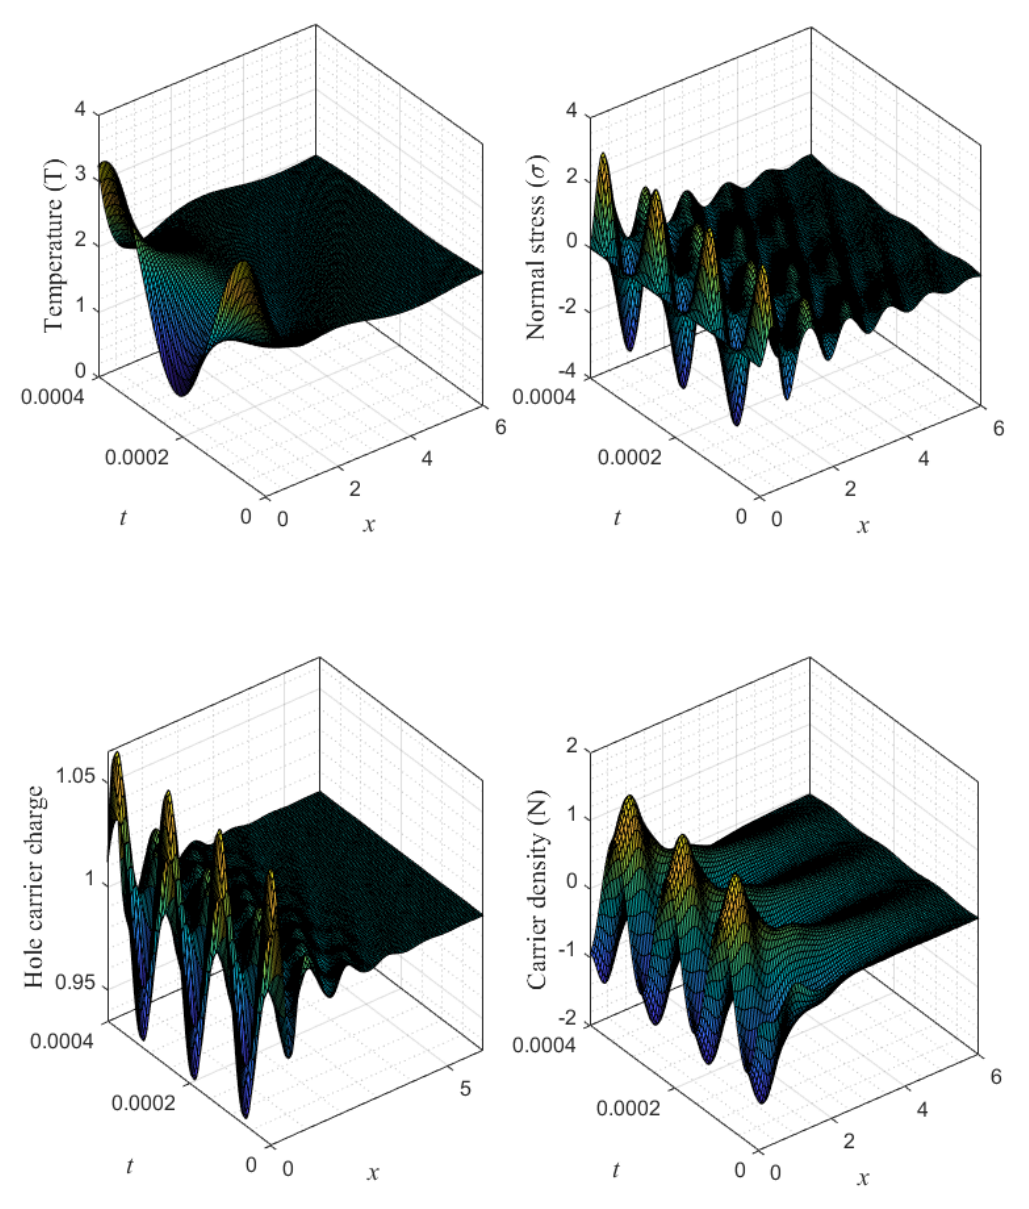
Figure 5. According to the DPL model, the 3D main field distributions change with distance and time when variable thermal conductivity and Hall current are at play.